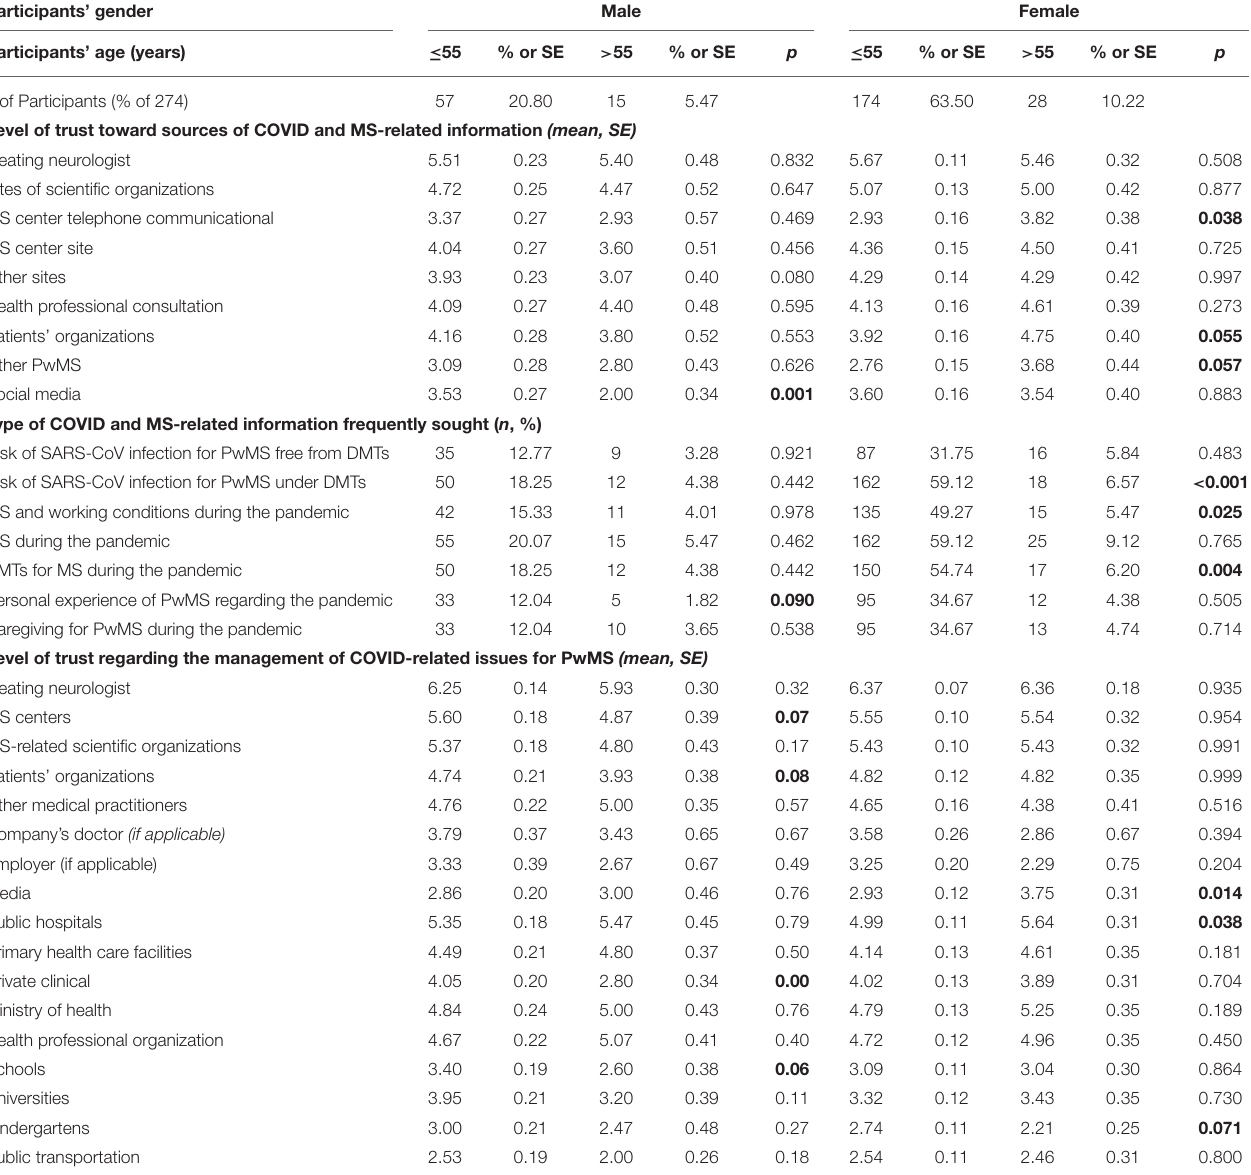
TABLE 4 | COVID-19 and multiple sclerosis awareness. Participants’